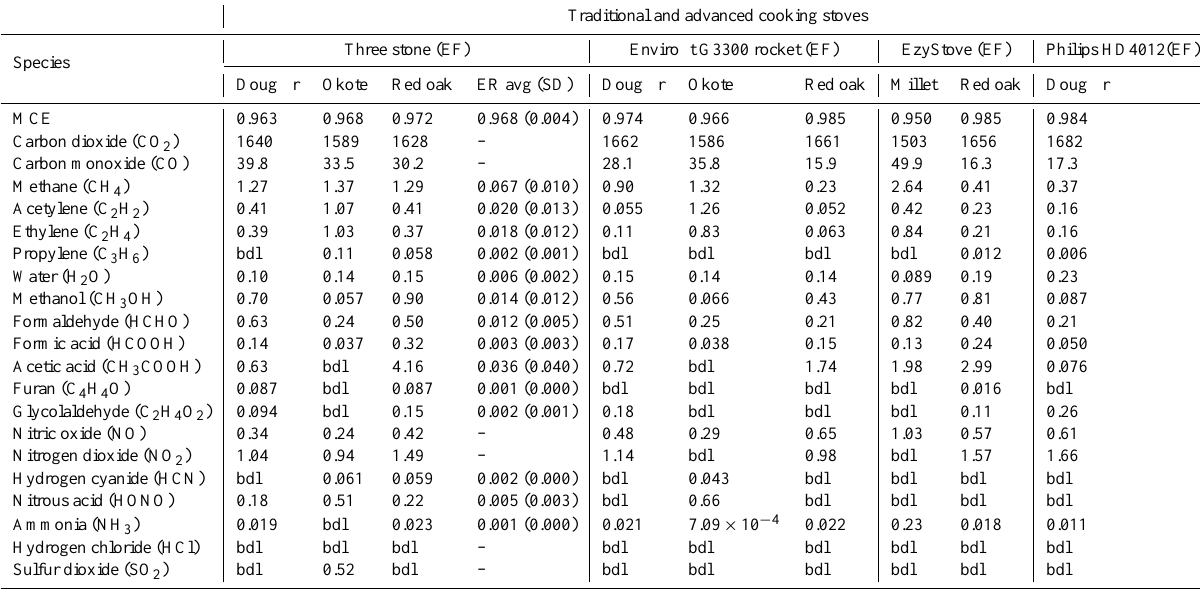
Table 4. Fire-average emission factors (gkg − 1 ) for cookstoves. The average emission ratios to CO for smoldering compounds are also shown for three-stone traditional cooking fires.